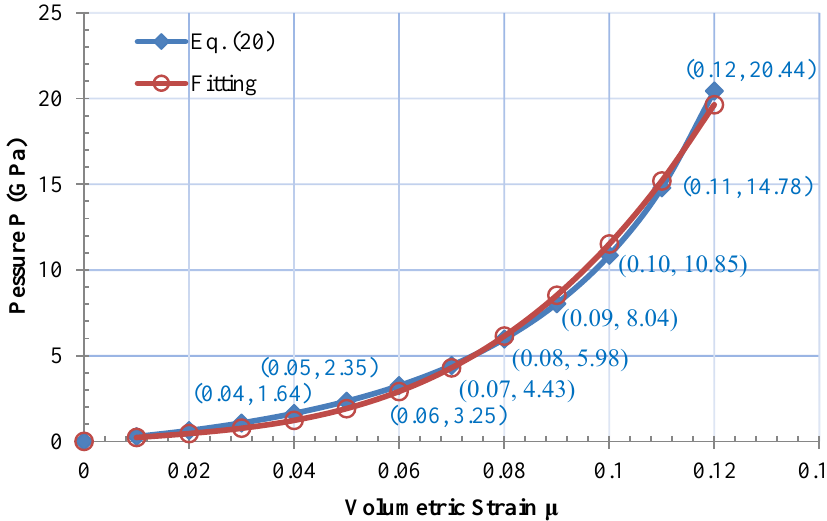
Figure 3. Hydrostatic pressure against volumetric strain response of Barre granite.